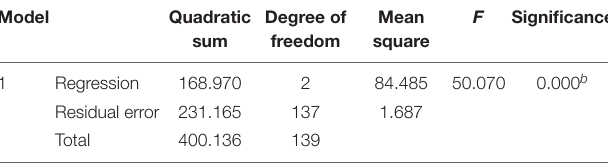
TABLE 12 | Adjustments for group type in the evaluation of novelty–complexity, intelligibility, and